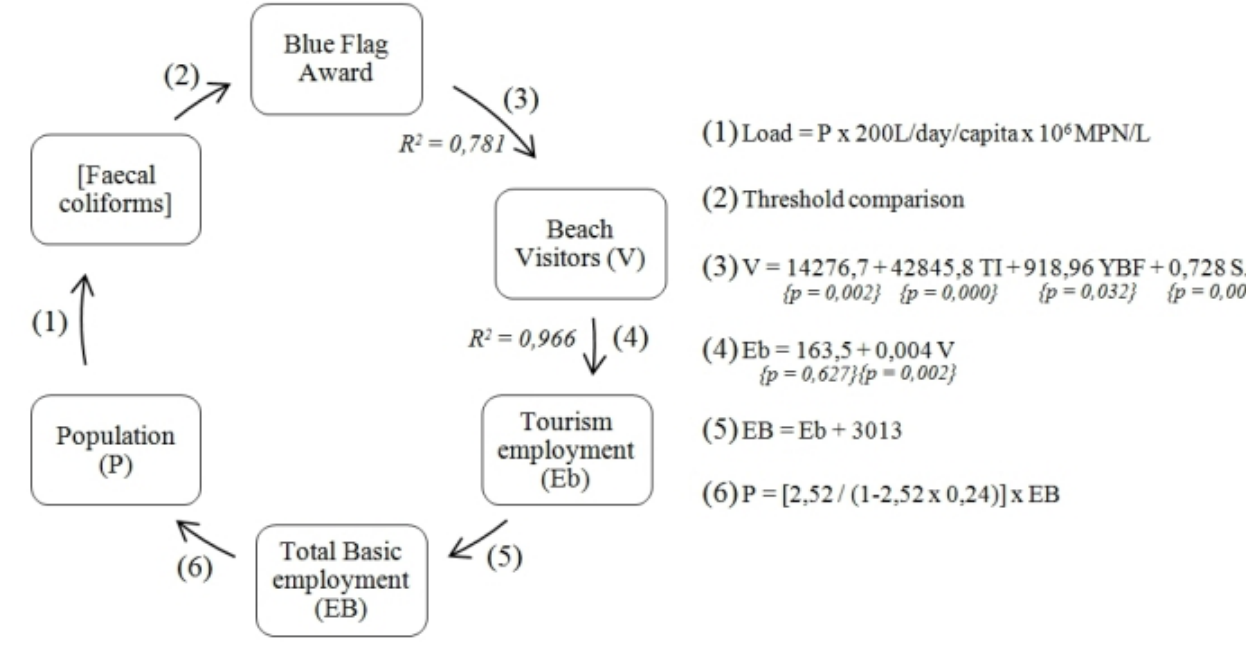
Fig. 6 . Chain of equations that link variables in the simulation model. V- beach visitors, TI- urban beach with intensive use. YBF- accumulated years for which the beach is awarded the Blue Flag (BFA), SA- area available to bathers, Eb- number of employed people in the HoReCa (hospitality) sector, EB - total basic employment in the area, P-